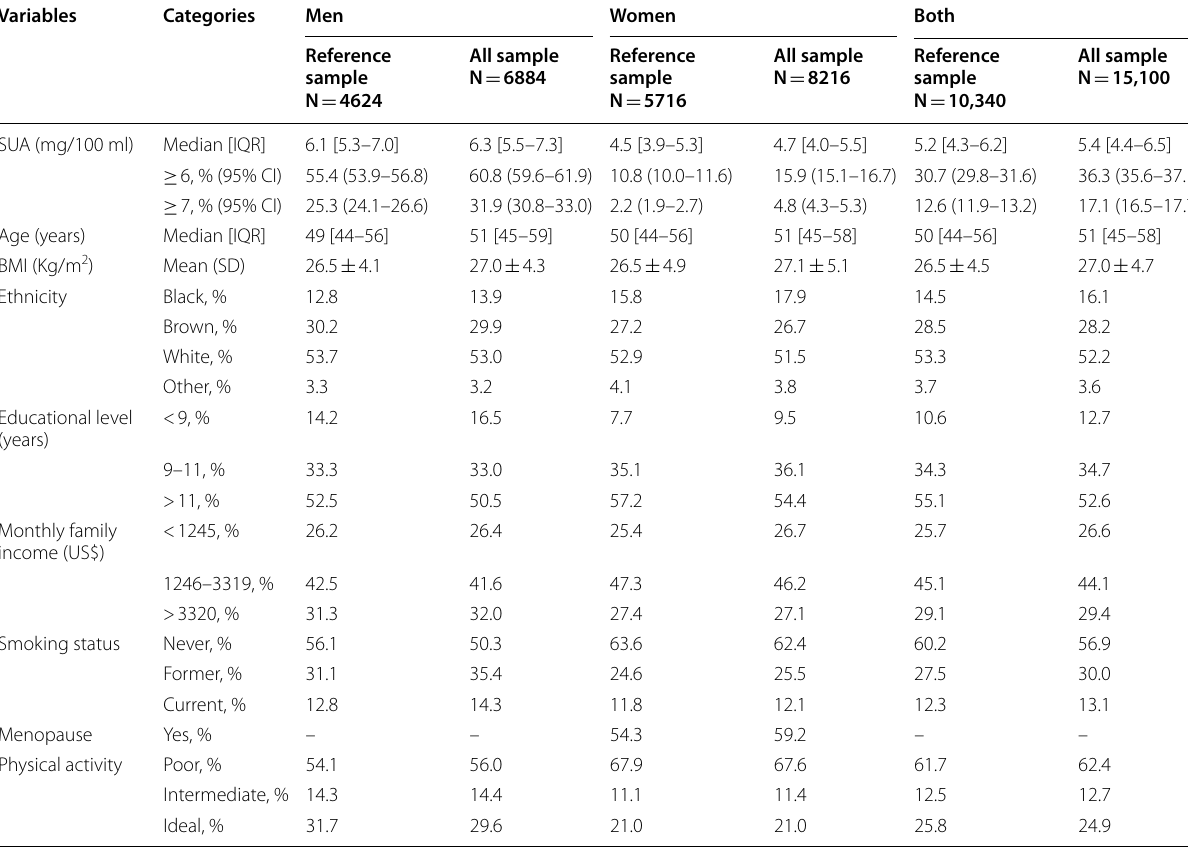
Table 1 Sociodemographic and habits characteristics, menopause and prevalence of hyperuricemia in reference and all sample for men and women